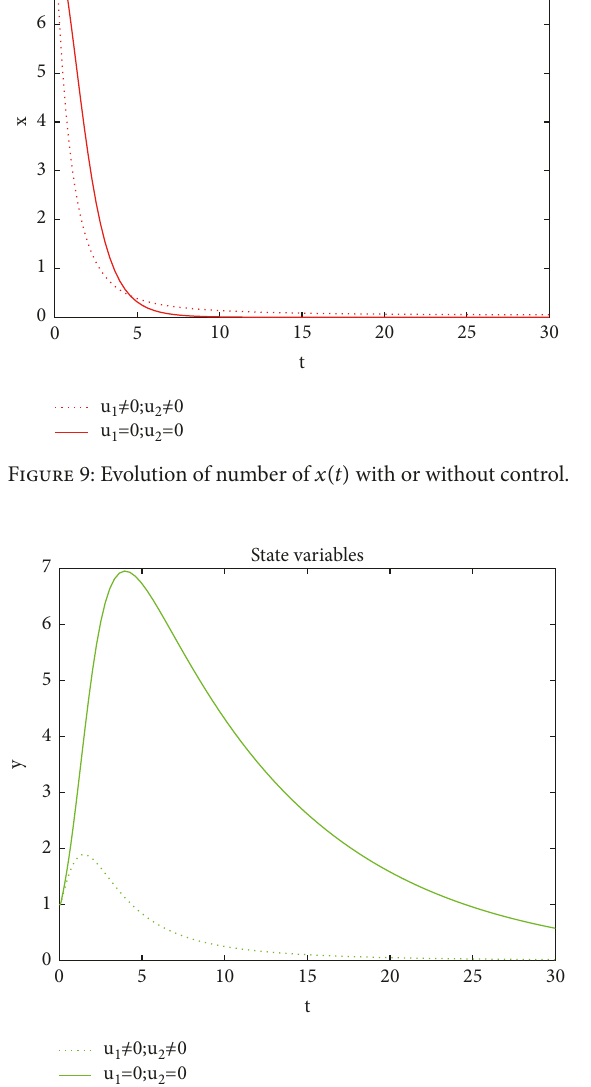
Figure 12: Optimal control function 𝑢 1 (𝑡),𝑢 2 (𝑡) for a controlled